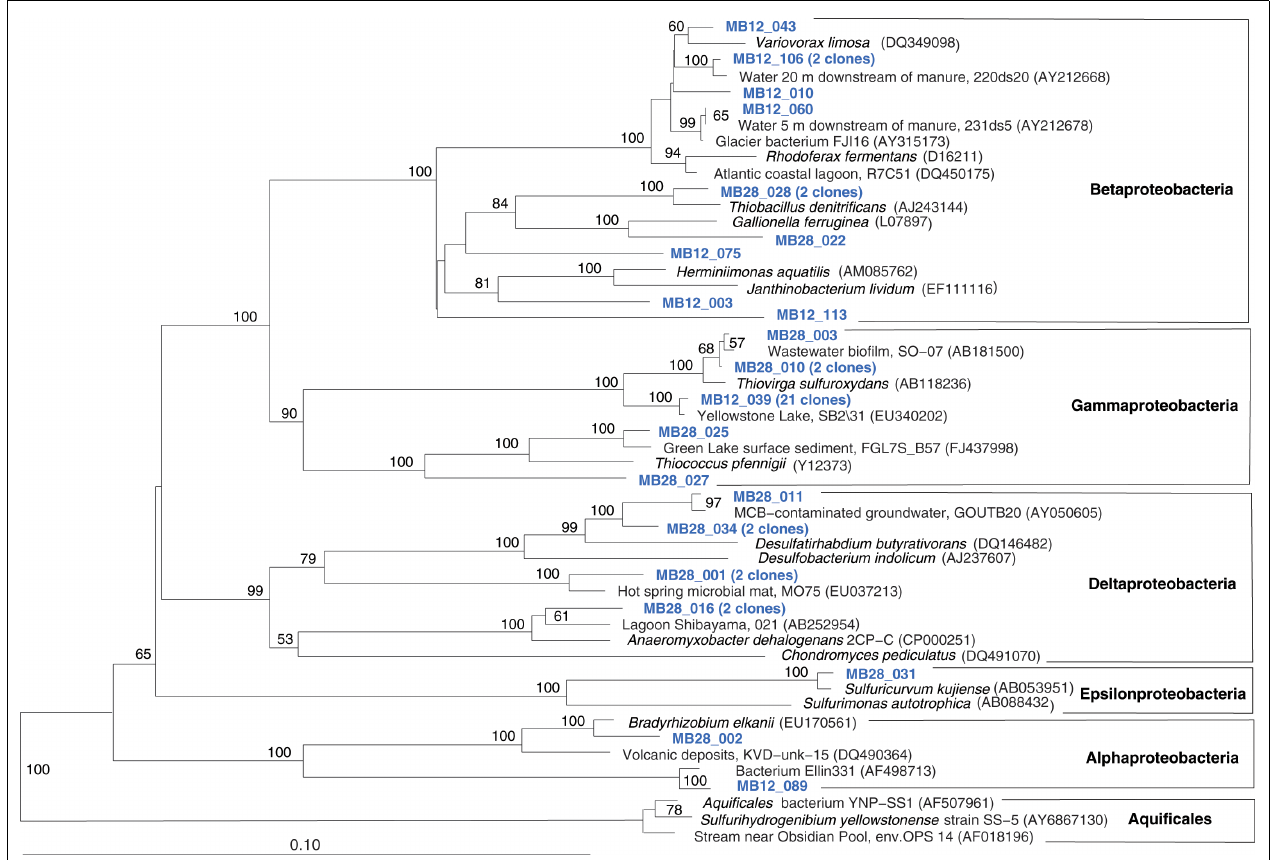
FIGURE 4 | Phylogeny of Mary BayWest 12 and Mary Bay Canyon 28 proteobacterial clones, based on E. coli 16S rRNA gene nucleotide positions 723–1491.